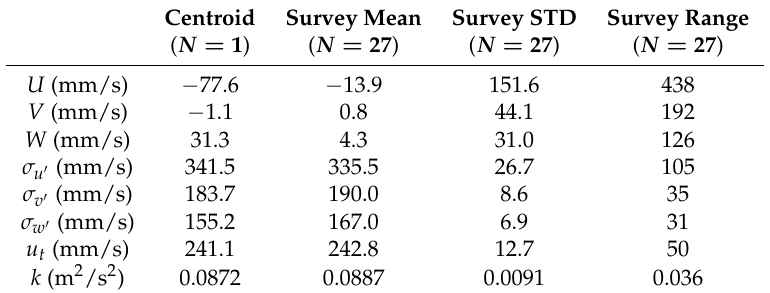
Table 2. Summary of turbulent flow conditions within the surveyed region of the net pen. Centroid Survey Mean Survey STD Survey Range